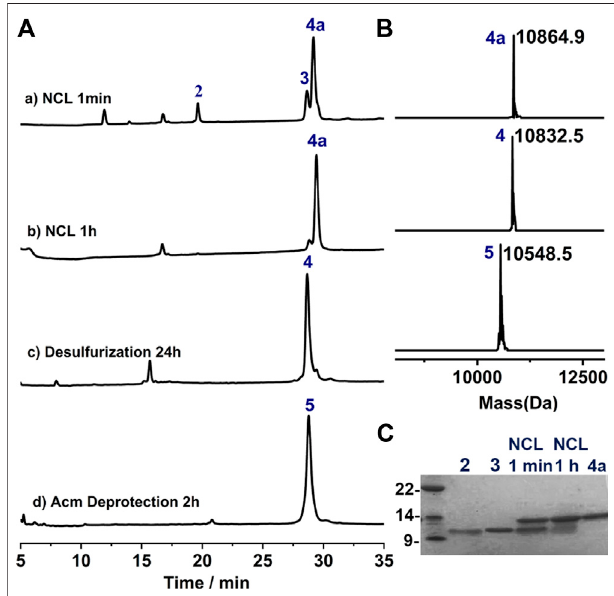
FIGURE 3 | (A) Analytical HPLC traces of one-pot NCL-Desulfurization reaction and the Acm group deprotection reaction. (B) Mass analysis of ligation reaction product 4a , 4 and 5 , respectively. 4a : observed mass 10,864.9 Da, calcd 10,865.6 Da (average isotopes); 4 : obsd. mass 10,832.5 Da, calcd. mass 10,832.6 Da (average isotopes); 5 : obsd. mass 10,548.5 Da, calcd. mass 10,548.5 Da (average isotopes). (C) Analytical SDS-PAGE analysis of the ligation